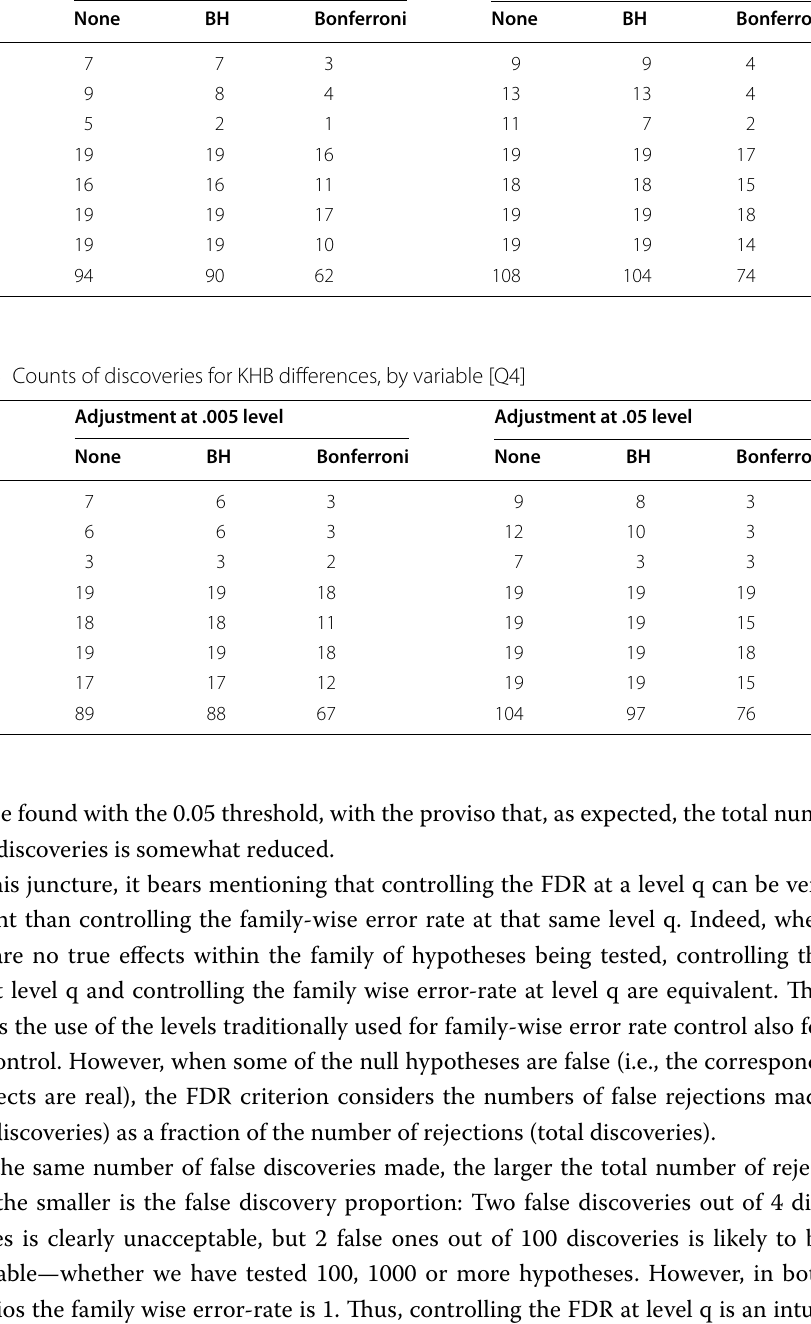
Table 4 Counts of discoveries for KHB differences, by variable [Q1] Adjustment at .005 level